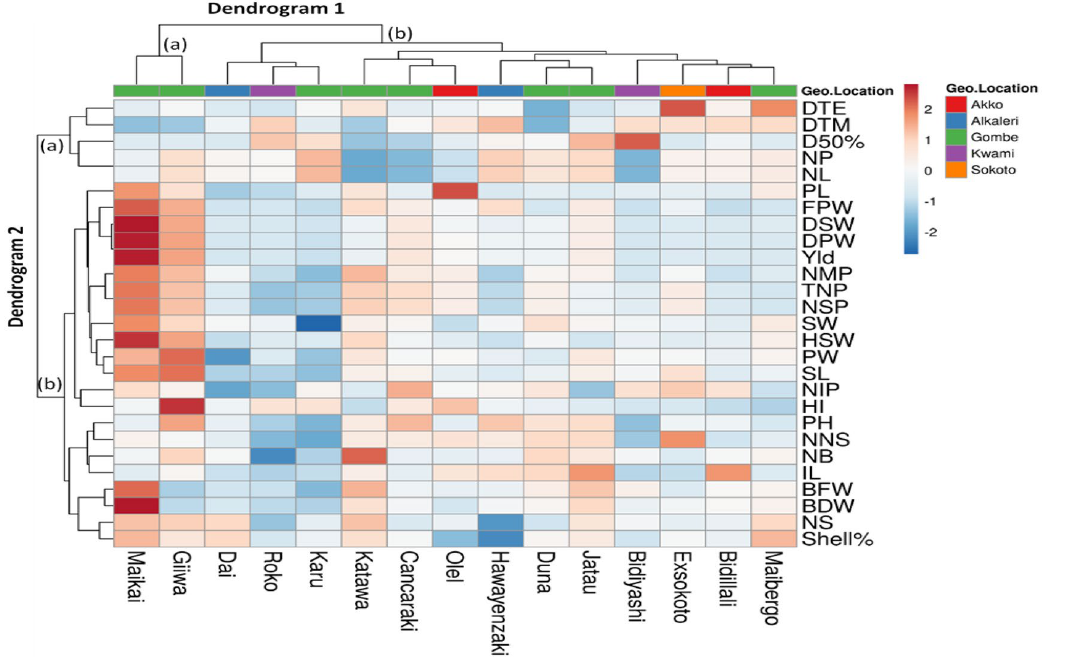
Figure 7. Heatmap and hierarchical clustering (double dendrogram) responses to morphological descriptors of Bambara groundnut landraces constructed using ClustVis tools (https:// bio. tools/ clust vis). The heatmap plot describes the relative abundance of each Bambara groundnut genotypes (columns) within each feature (rows). The color code (blue to dark red) displays the row z-score: red color indicates high abundance, blue color low abundance. The dendrogram shows hierarchical clustering of Bambara groundnut genotypes based on the Euclidian as the measure of distance and Ward’s cluster agglomeration